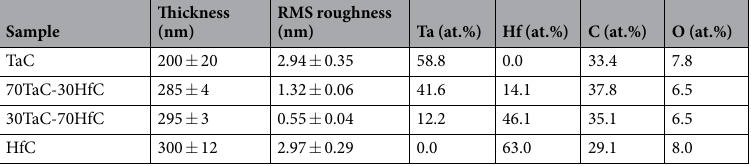
Table 1. Thickness, RMS roughness obtained from AFM measurements and chemical compositions obtained from XPS.